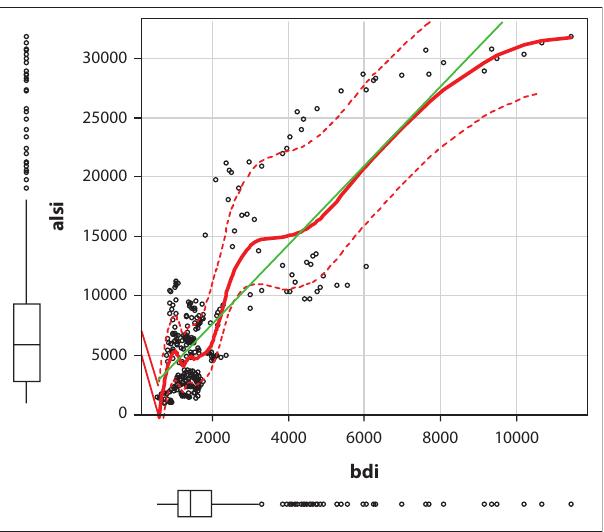
FIGURE 5: Scatterplot with fit lines and marginal boxplots showing correlation between All Share Index and Baltic Dry Index pre-break, May 1985–June 2008. TABLE 2: Grander causality test results for All Share Index versus Baltic Dry Index for the full period and pre- and post-break, 1985–2016. Period